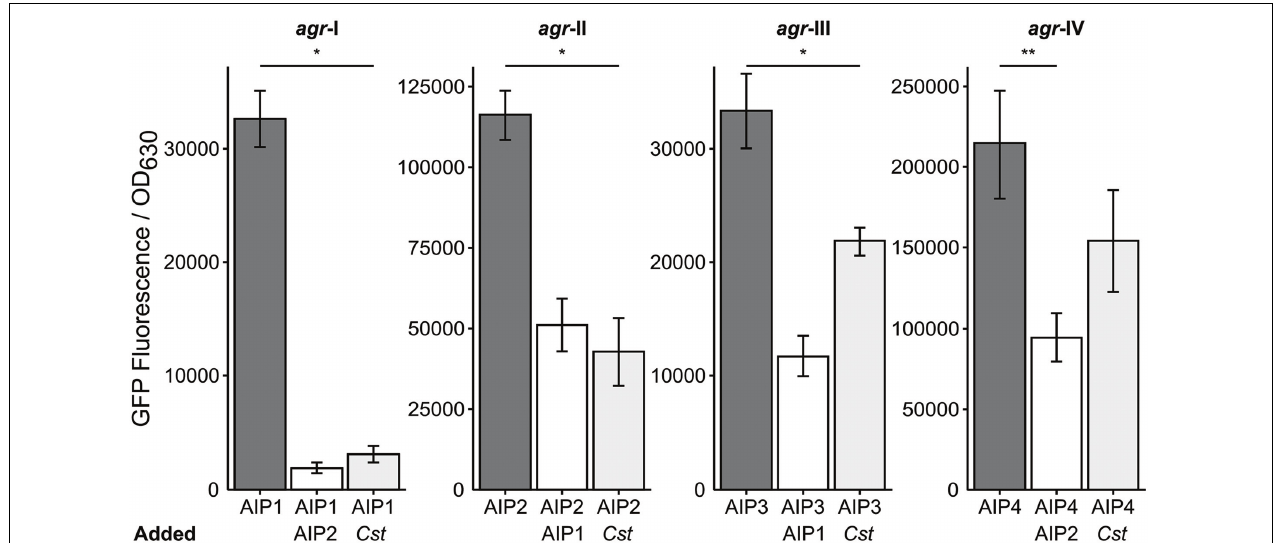
FIGURE 6 | Corynebacterium striatum CFCM inhibits signaling of S. aureus agr types I, II, and III. For each respective agr type, post-exponential phase S. aureus CFCM from that same type was used to induce an agrP3:gfp reporter. CFCM containing AIP-1 was used to inhibit S. aureus agr types II and III strains and CFCM containing AIP-2 was used to inhibit S. aureus agr types I and IV strains (white bars). Cultures grown in the presence of inducing AIP-containing S. aureus CFCM and C. striatum CFCM showed pronounced inhibition of agr types I, II, and III and no significant inhibition of agr type IV (light gray bars). GFP was measured as fluorescence/OD 630 ( n = 3). Error bars represent SEM. Data were analyzed by two-tailed Student’s t -test with Bonferroni correction for multiple testing ( ∗ p < 0.005 and ∗∗ p <